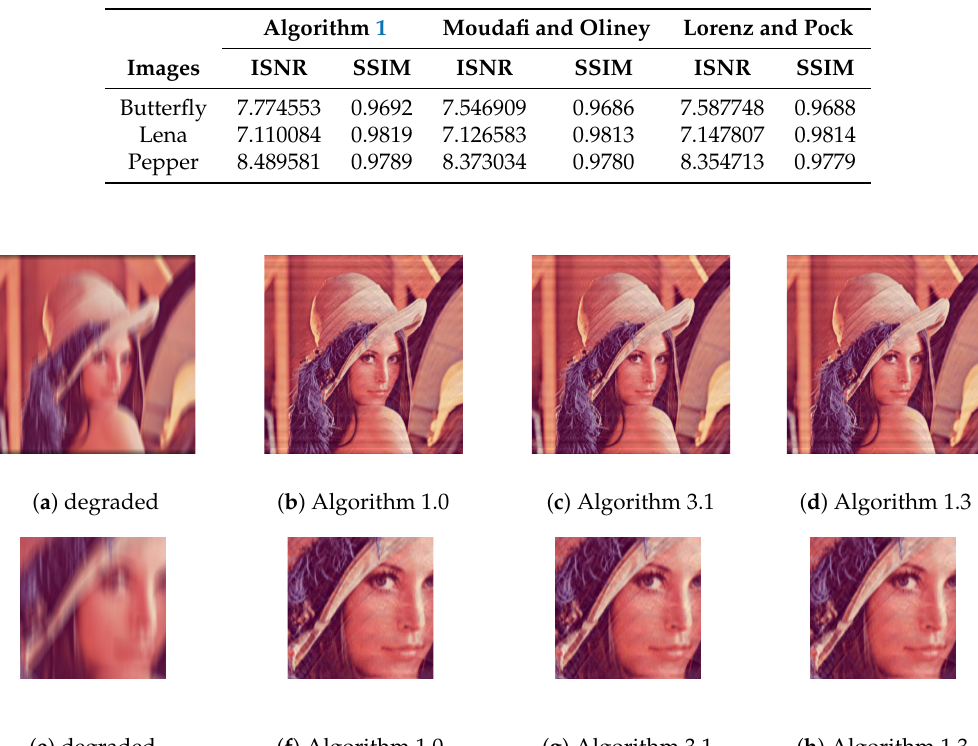
Figure 3. Degraded and restored ( a – d ) Lena images and ( e – h ) enlarged Lena images by the various algorithms.